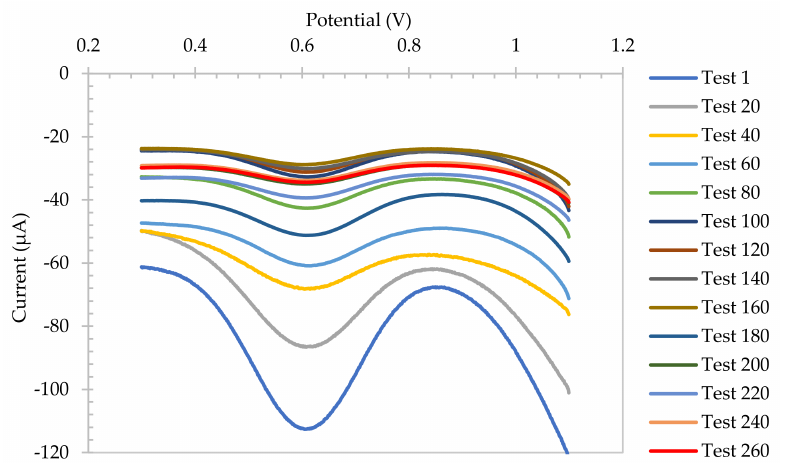
Figure 7. Square wave voltammograms of SA electrode every 20 tests, scanned every half an hour over 10 days, with a total of 260 tests.